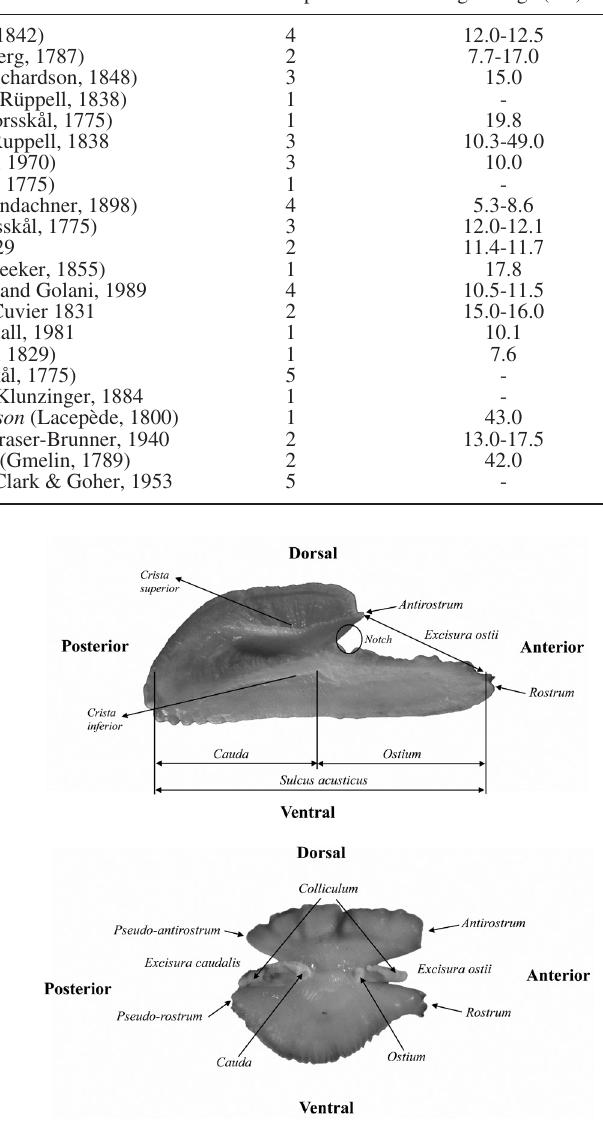
Table 1. − Taxonomical identification, area and total length range of Lessepsian species studied in the Mediterranean Sea. Order